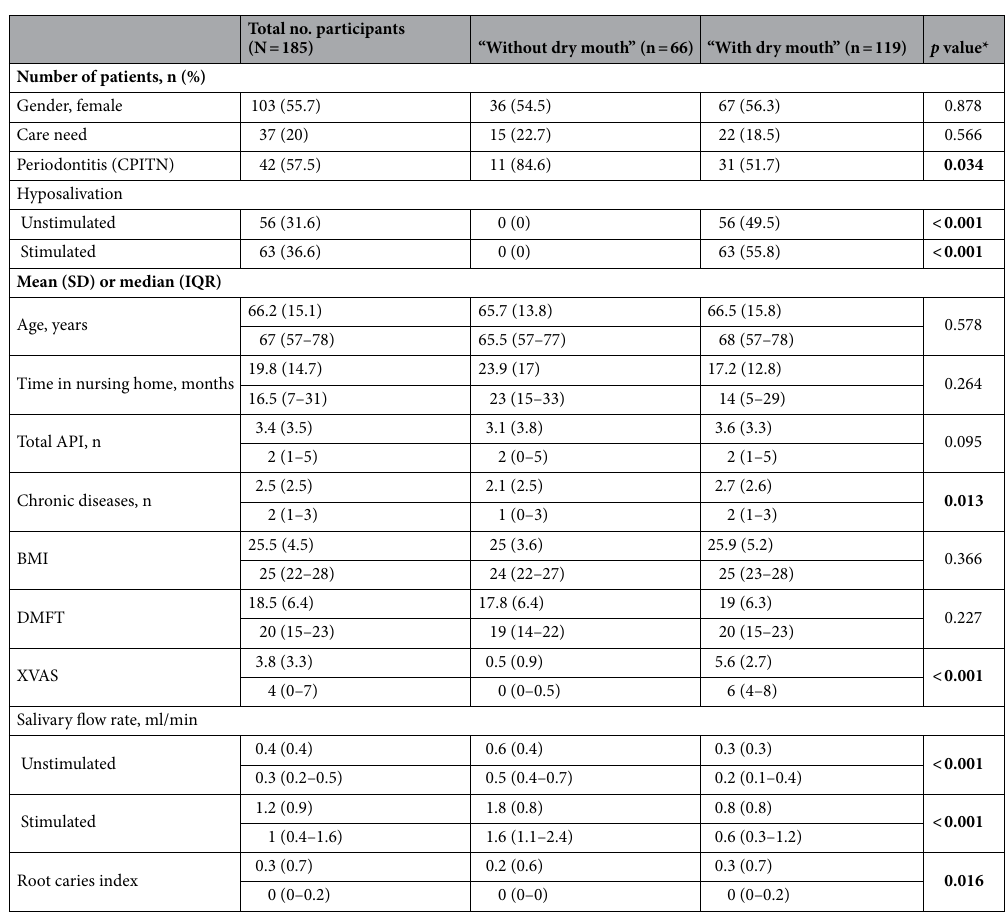
Table 1. Clinical characteristics. API active pharmaceutical ingredients, BMI body mass index, CPITN community periodontal index of treatment needs, DMFT decayed missed filled teeth, IQR interquartile range, SD standard deviation, XVAS xerostomic visual analog scale. * p < 0.05 indicates statistical significance between “Dry mouth” and “Without dry mouth” patients (bold numbers) evaluated using Fisher’s Exact Test or Mann– Whitney U Test.